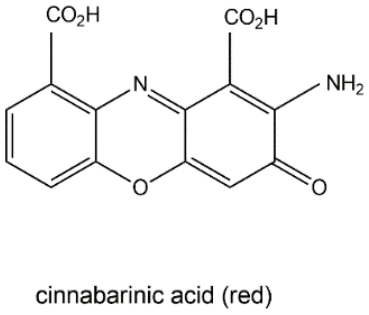
Figure 10. Cinnabarinic acid.